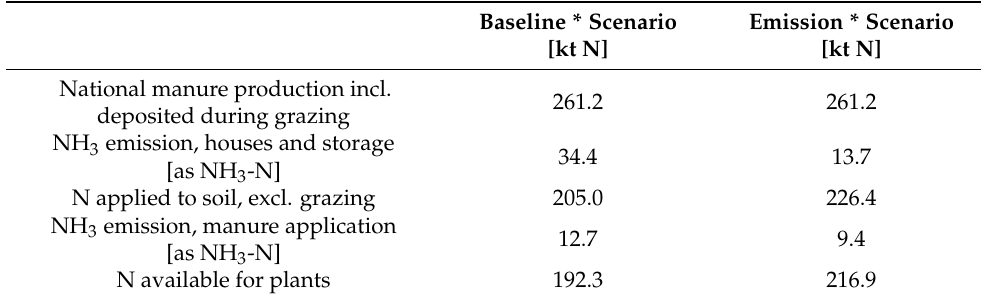
Table 3. Total yearly nitrogen from all animals in Denmark in manure and ammonia emission used in the baseline and emission scenario. Based on 2012 data.